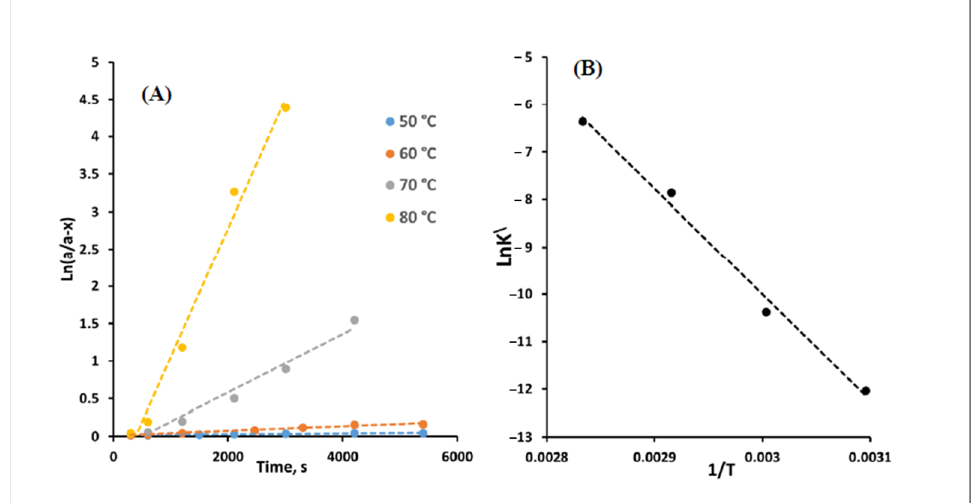
Figure 7. ( A ) Semi logarithmic plot for the first-order reaction of NFZ and potassium borohydride and ( B ) Arrhenius plot for the reaction of NFZ and potassium borohydride.